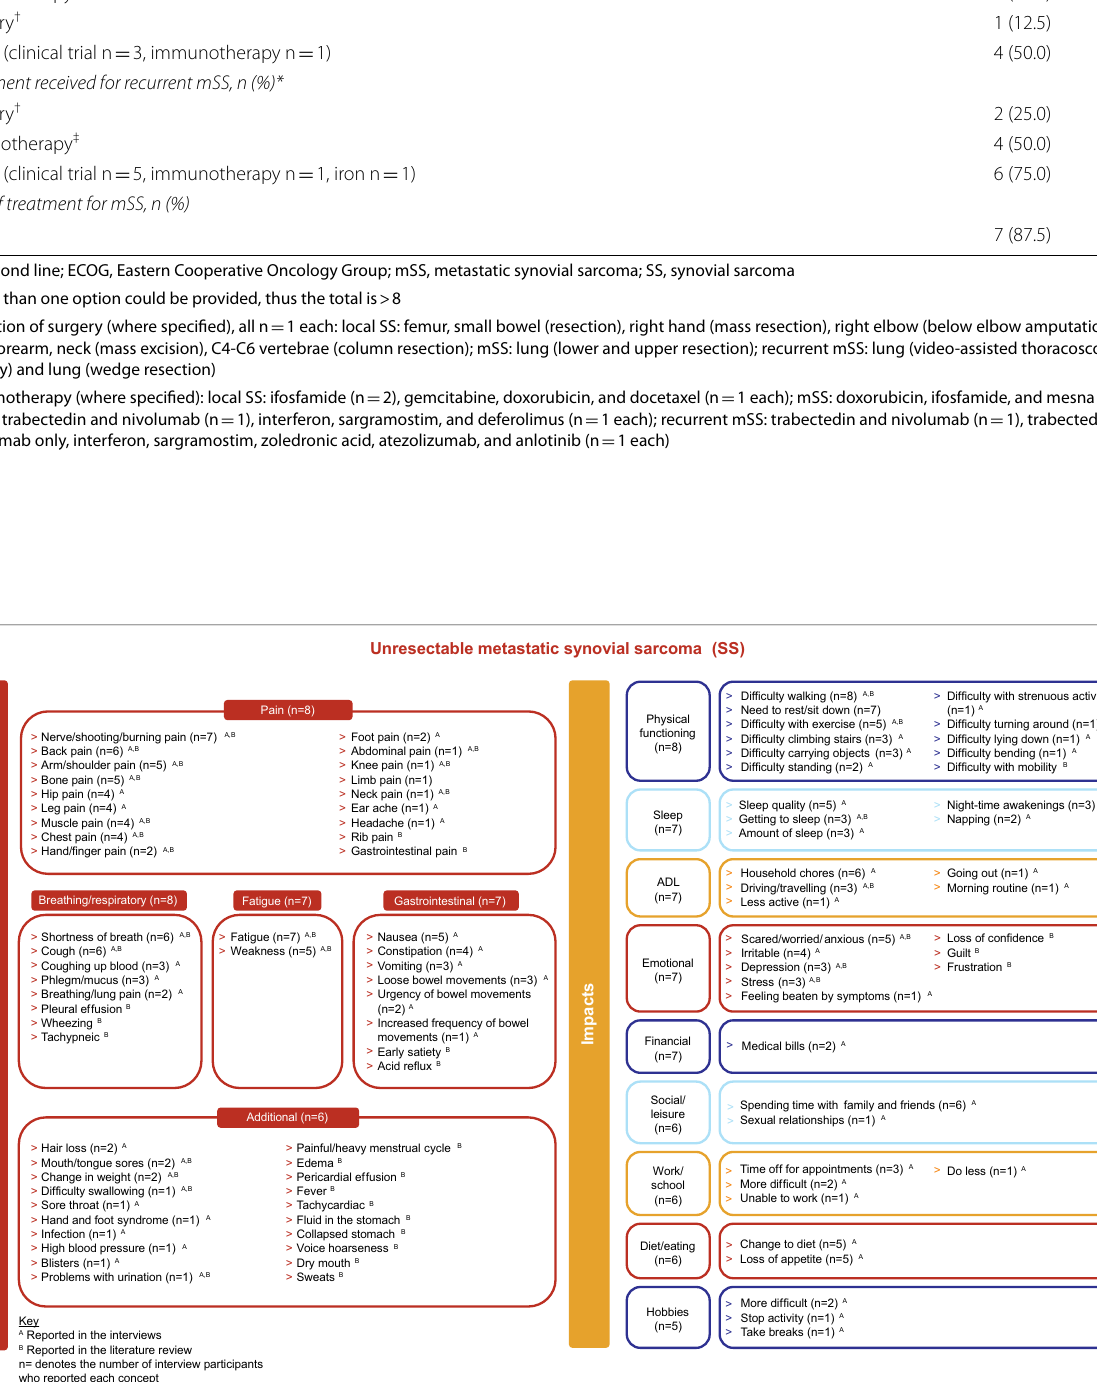
Fig. 2 Conceptual Model of mSS. ADL, activities of daily living; mSS, metastatic synovial